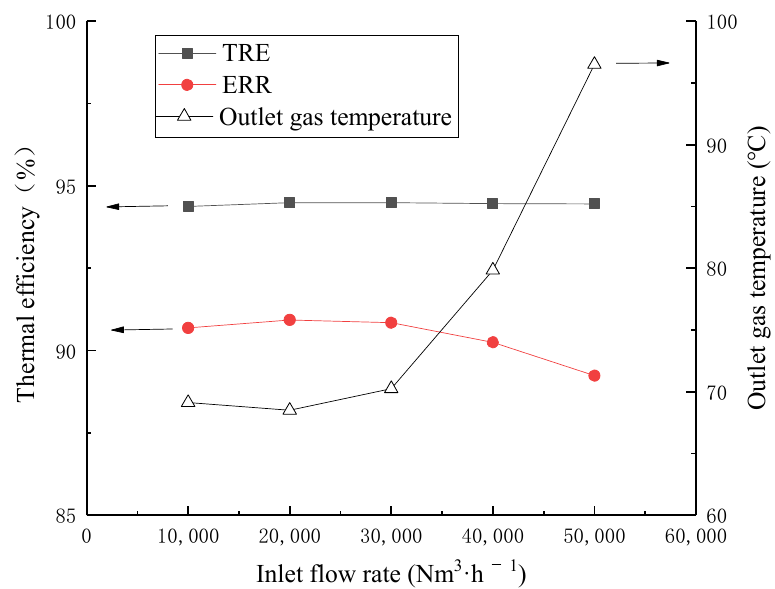
Figure 8. Effect of inlet flow rate on heat transfer efficiencies.